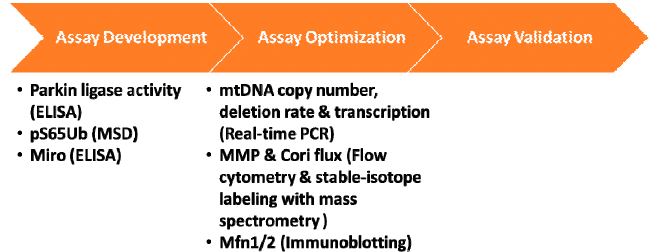
Figure 3. PINK1-Parkin pathway biomarkers. The schematic demonstrates the three essential phases for a biomarker assay: development, optimization and validation. Most biomarker efforts for PINK1 and Parkin fall under the assay development and assay optimization phases. MJFF-funded studies are listed along with the platform used for analysis in parenthesis. The assay development efforts use recombinant proteins while assay optimization efforts are in PBMCs derived from PINK1 and/or PRKN mutation cases and controls.